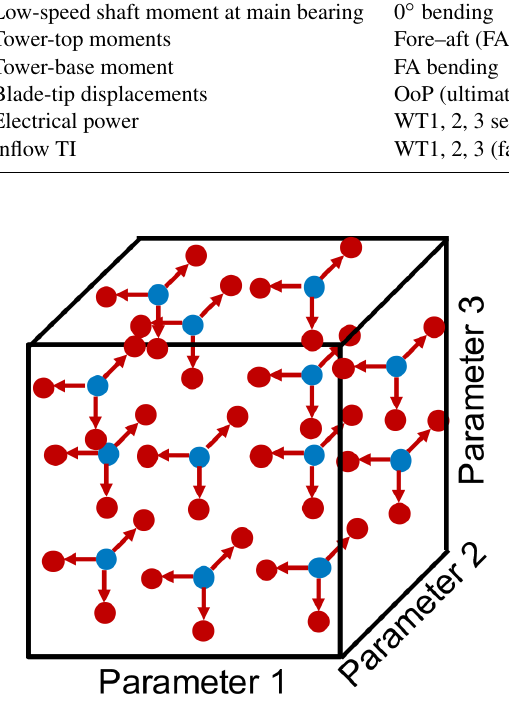
Figure 3. Radial EE approach representation for three input pa- rameters. Blue circles indicate starting points in the parameter hy- perspace. Red points indicate variation in one parameter at a time.